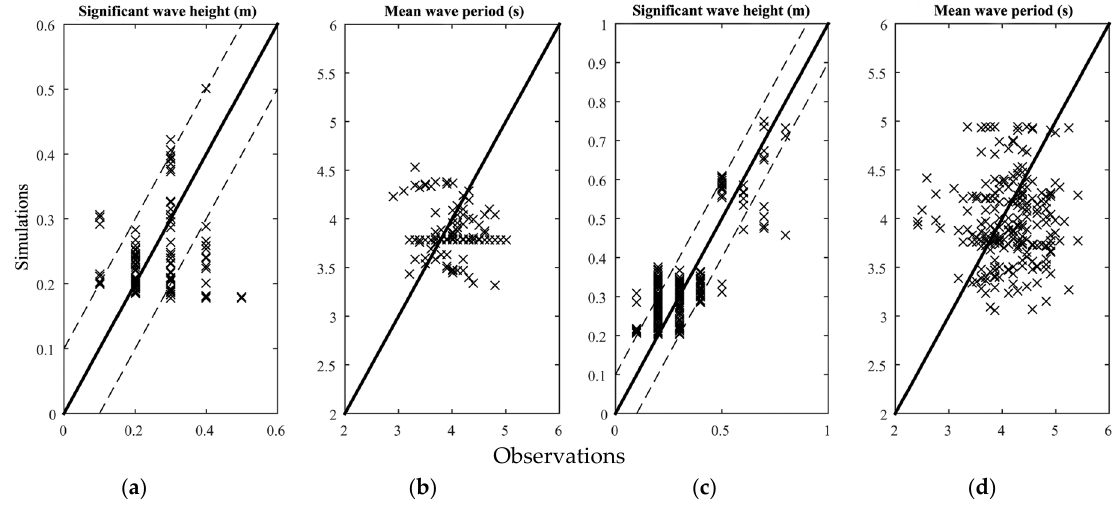
Figure 3. Comparisons between observed and simulated H s and T 01 at buoy sites under normal conditions: ( a ) H s from 1 to 8 April 2014; ( b ) T 01 from 1 to 8 April 2014; ( c ) H s from 29 August to 5 September 2014; and ( d ) T 01 from 29 August to 5 September 2014. The solid lines represent the perfectly-matching curve while the dashed lines showing the reliable region of the buoy measurements ( ± 0.1 m).